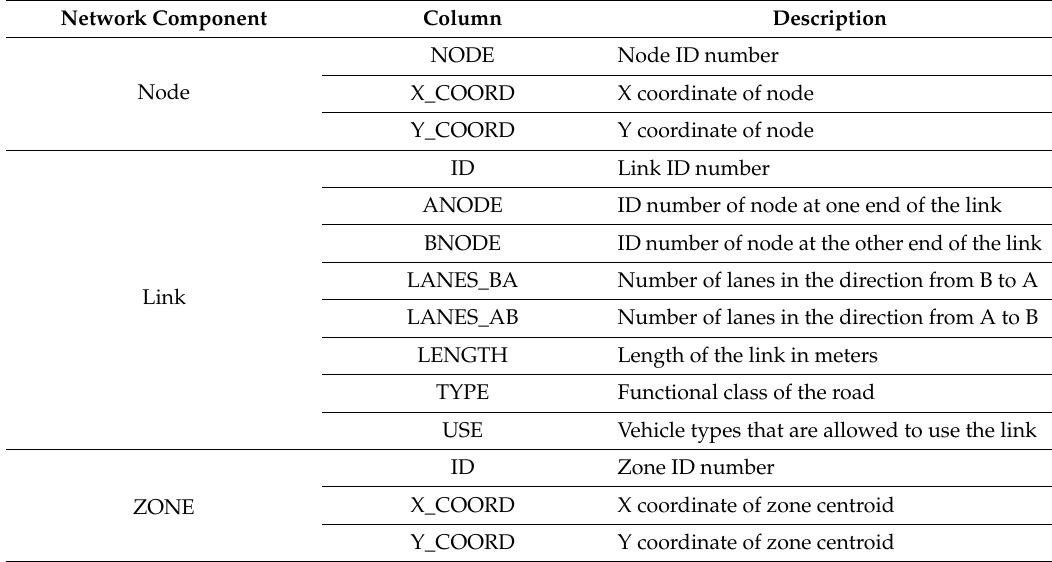
Table 2. Required information for network input